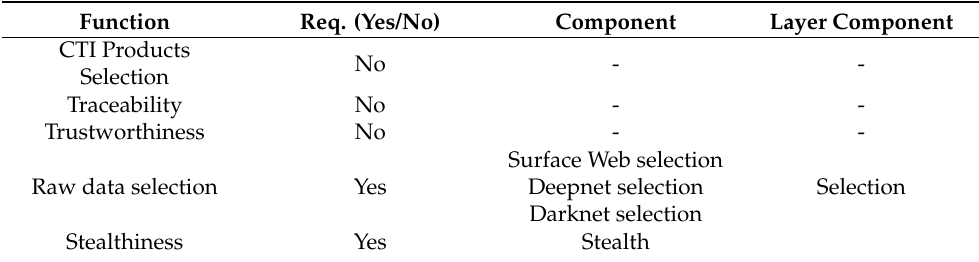
Table 2. Application of CTI Reference Model: Selection Layer.